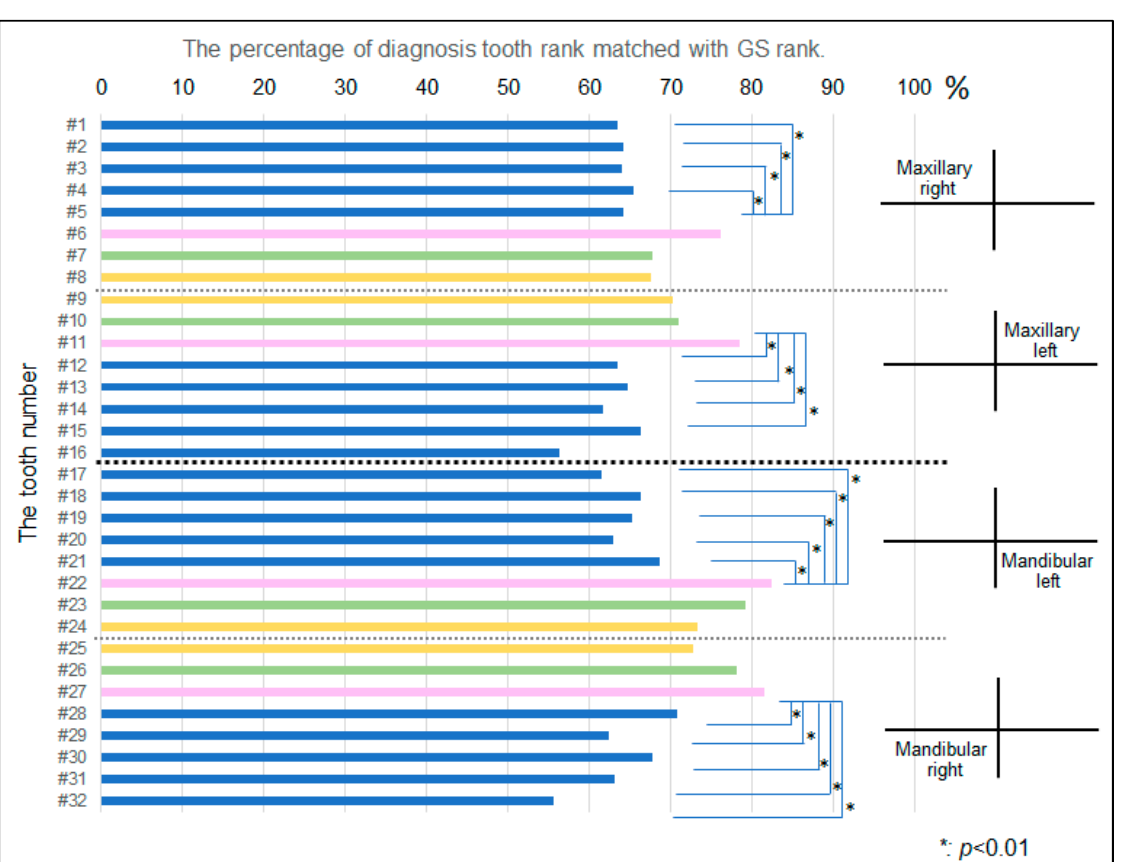
Figure 5. Percentage of diagnosis tooth rank matched with GS rank. The matching percentage was significantly different among the type of tooth (<0.01, one-way ANOVA), and canines (#6, 7, 11, 22, and 27) indicated a significantly higher matching rate than premolars and molars ( p < 0.01). Blue: premolars and molars, Pink: Canined; Green: Lateral incisors; Yellow: Central Incisors.